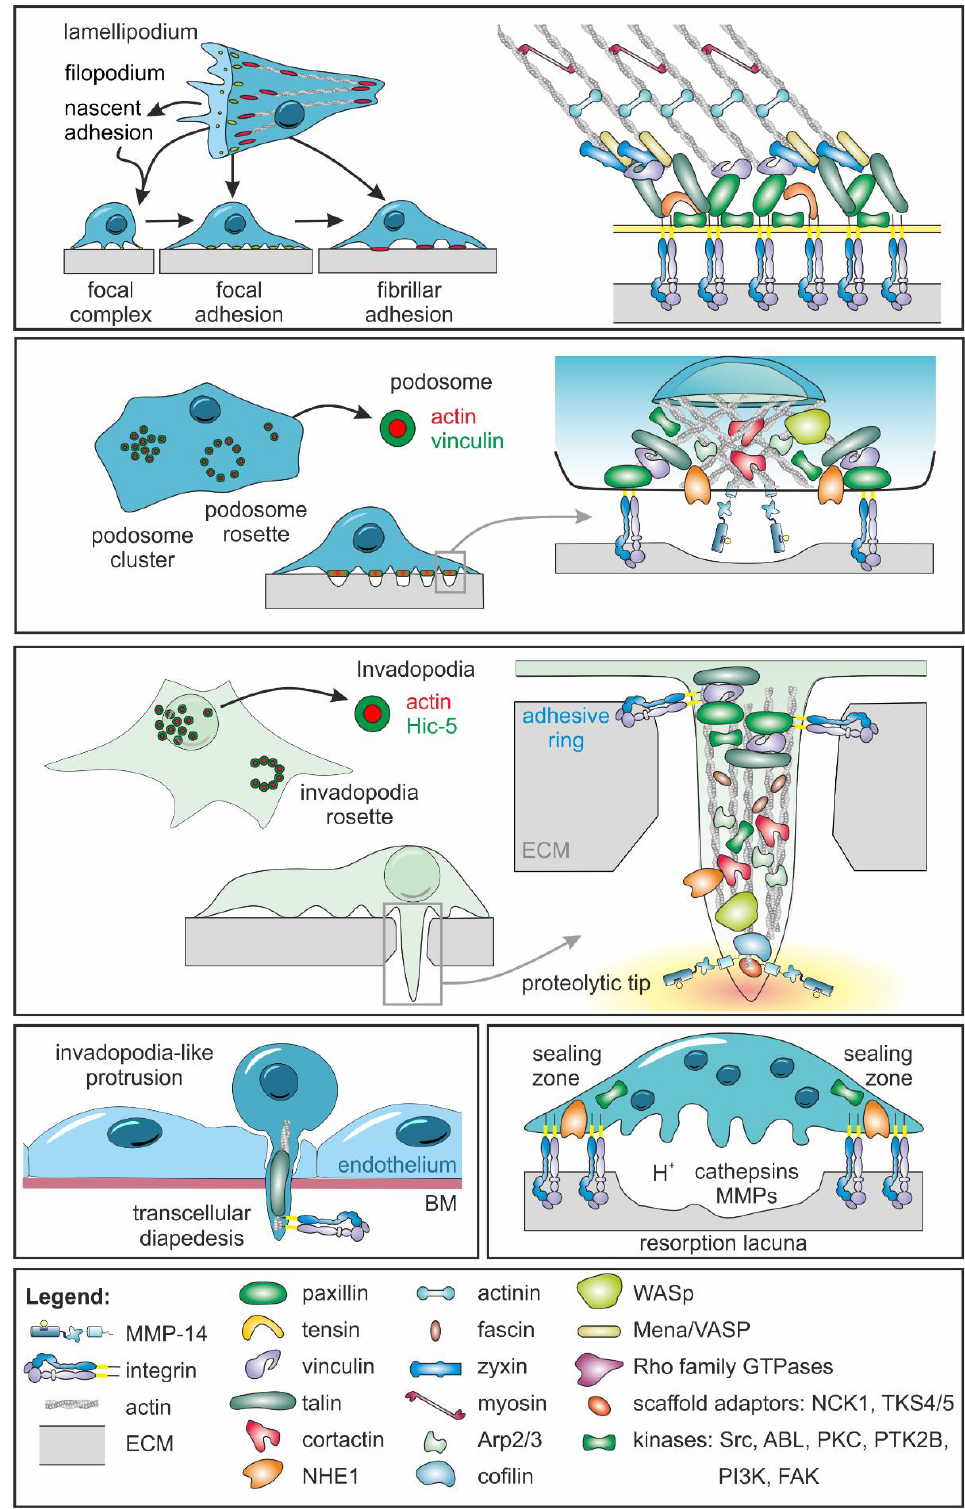
Figure 6. Cells employ adhesive or proteolytic adhesome structures with different composition and mesoscale organization. Details can be found in the text and in Table 2.